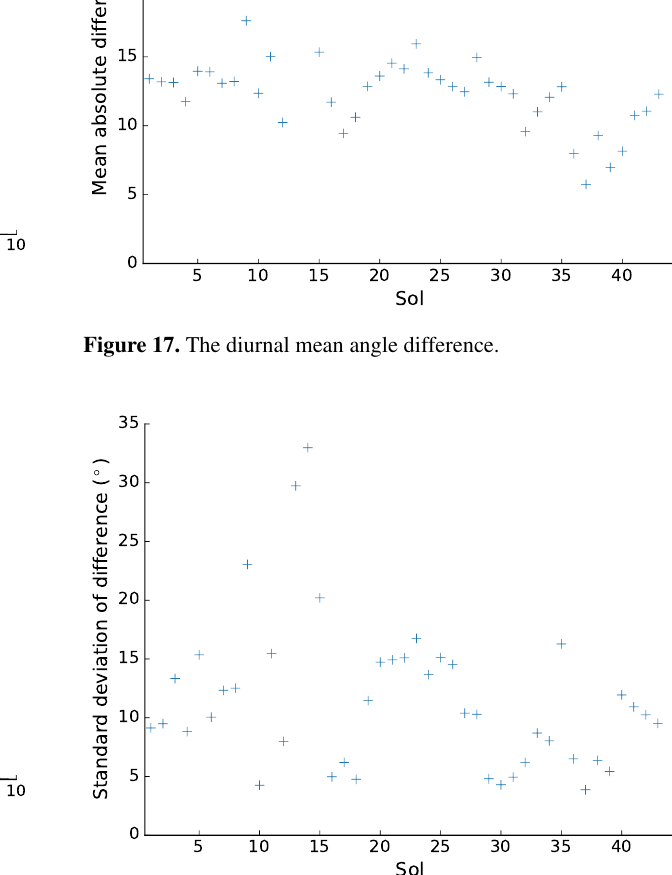
Figure 16. The distribution of R values during sols 378–2245.